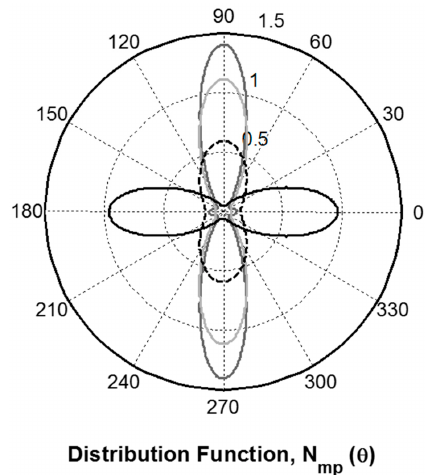
Figure 6. The most probable orientation distribution determined for the hand drawn B. terrestris silk fibre (black trace). A. illawarra fibres (dashed black trace) [13] presented along with those of B. mori and S. c. ricini cocoon (dark grey trace) and N. edulis dragline (light grey trace) silks [16]. The 0° of the polar plot coincides with the fibre direction.